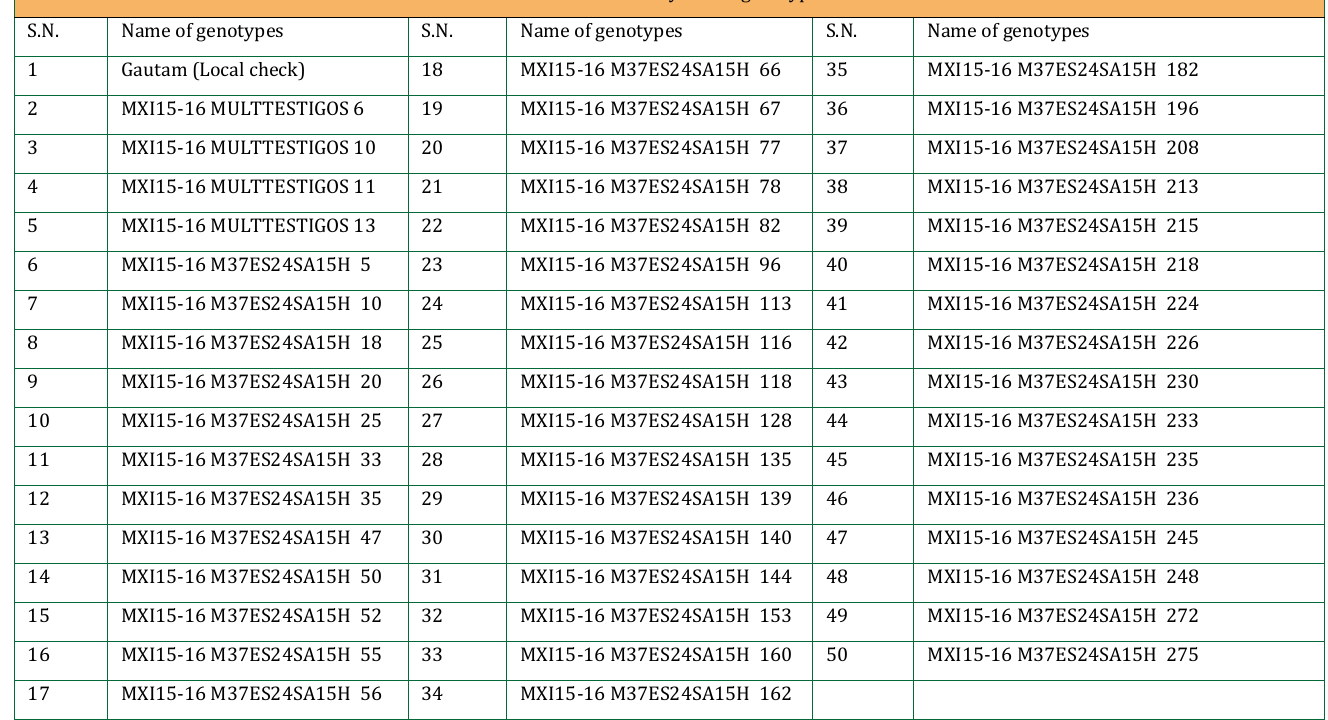
Table 1: List of fifty wheat